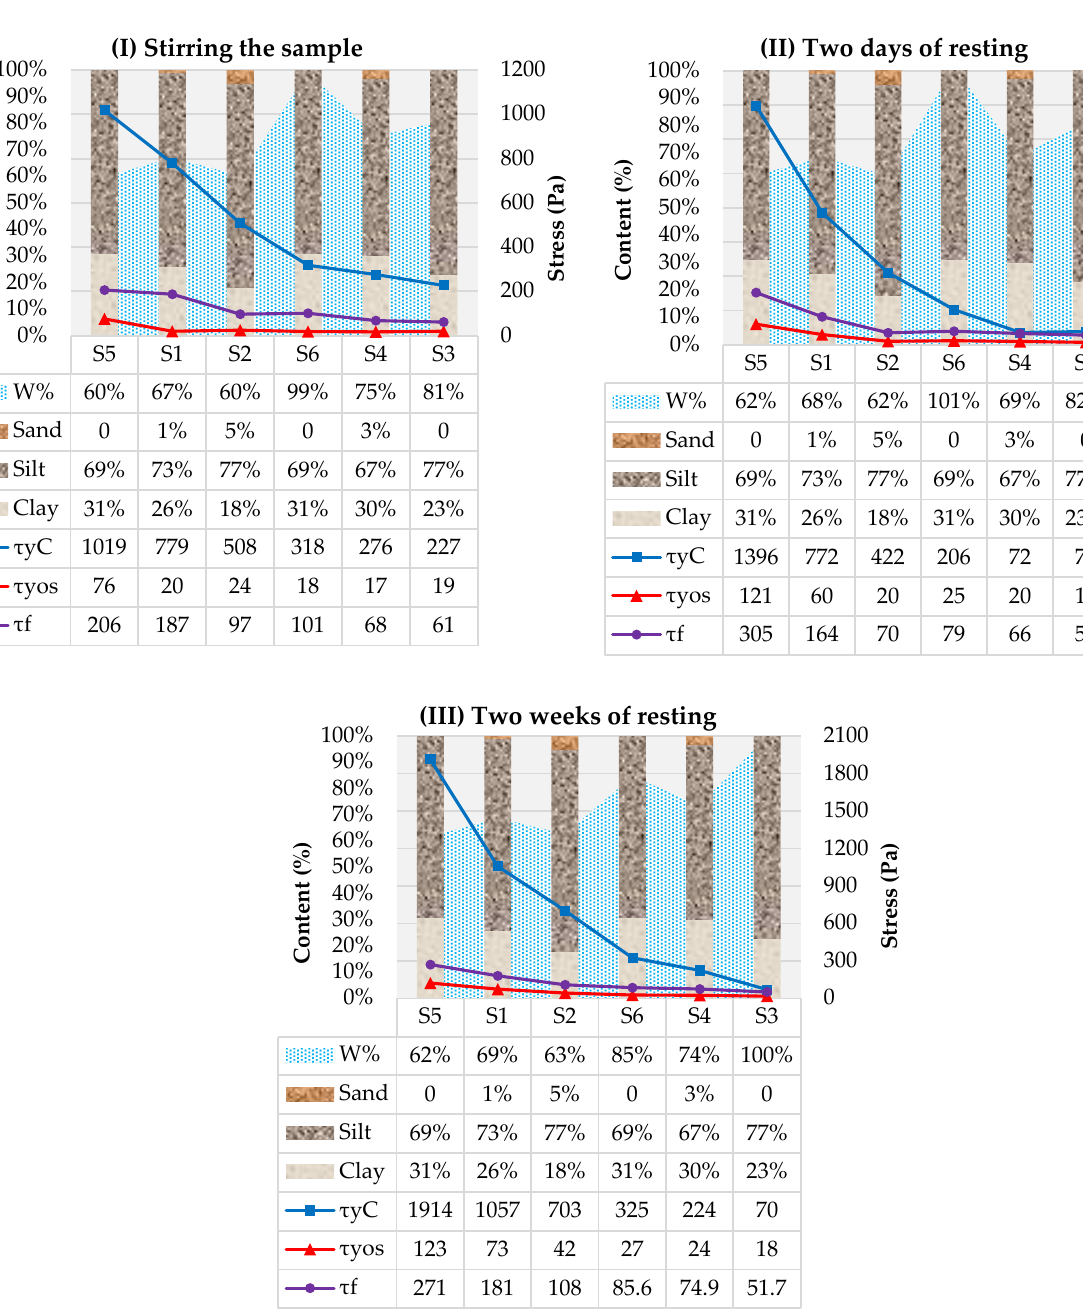
Figure 10. The rheological parameters of sediment samples with the water contents and grain-size fractions for three steps (I) Stirring the sample, (II) Two days of resting, (III) Two weeks of resting.